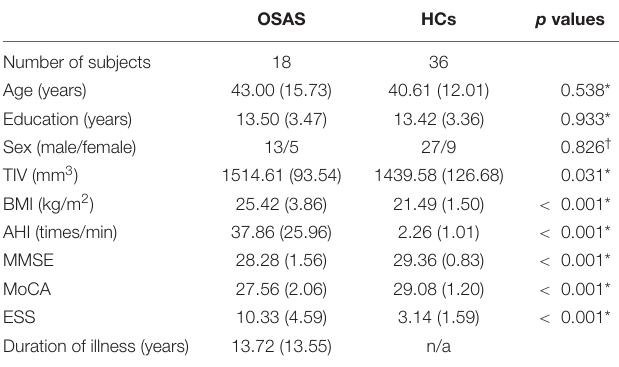
TABLE 1 | Demographic and clinical data and (standard deviations) by